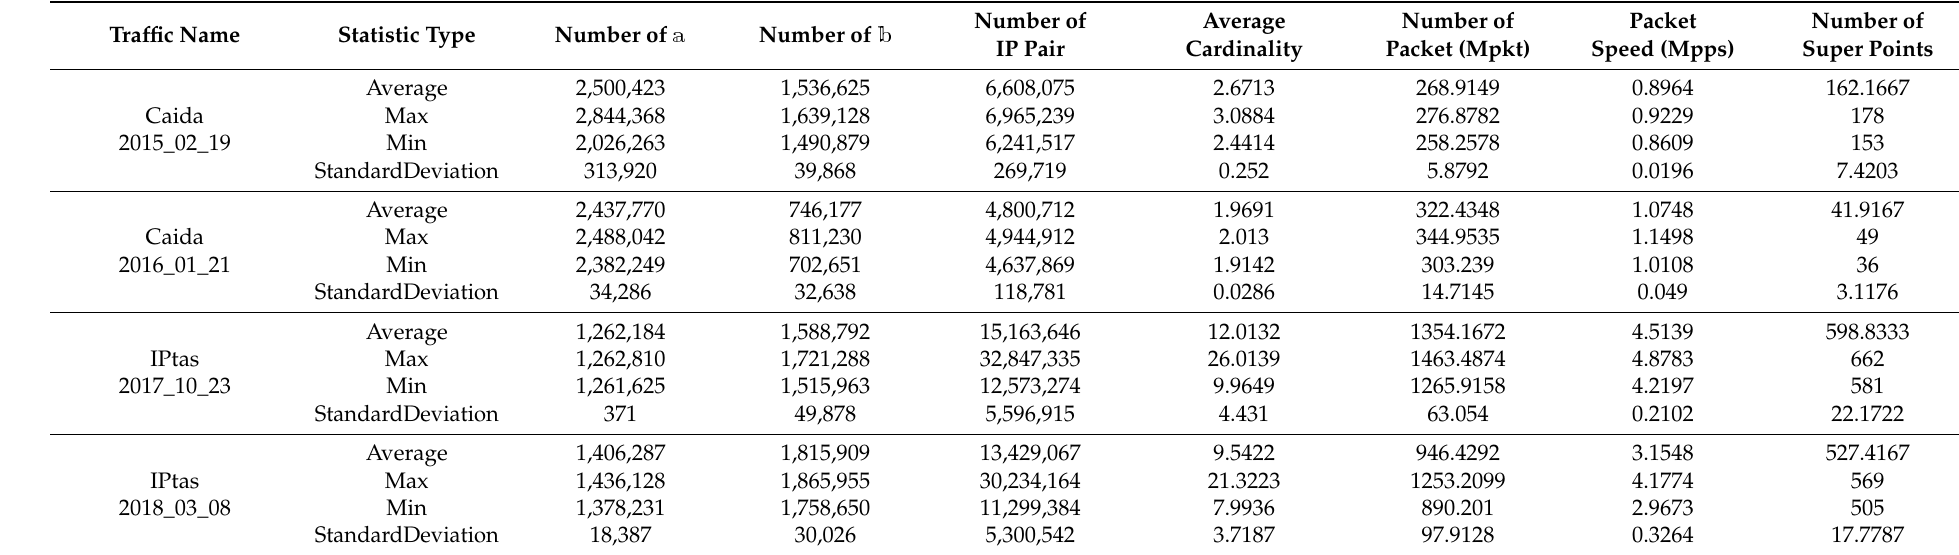
Table 2. Statistics of experiment